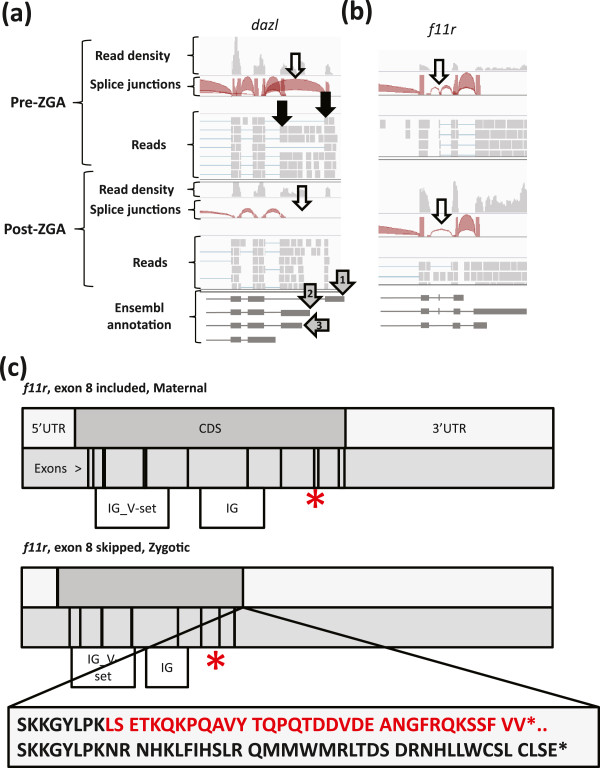
Dazl TSS switching and f11r exon
skipping switch. (a) A screenshot from Integrative Genomics
Viewer shows that dazl has been transcribed from at least two
TSS’s in the maternal transcriptome; grey arrows 1–3 at bottom
indicate Ensembl annotated TSSs. Black arrows in the upper panel indicate reads
supporting promoter 1 (rightmost black arrow) and promoter 2/3 (leftmost black
arrow; our data cannot distinguish between TSS 2 and 3). A white arrow in the
upper panel points at a splice junction ‘bridge’ (red), symbolizing
the splice junction for the most distal first exon. The thickness of splice
junction symbols is correlated with the number of reads supporting the
junction. Post-ZGA transcripts lack the most 5’ exon as can be observed
from the absence of reads supporting the splice junction originating from this
exon (white arrow, bottom panel). (b) Pre-ZGA an f11r isoform
with exon 8 included is present (white arrow, top panel). Post-ZGA a different
f11r isoform, this one with exon 8 lacking, has been transcribed
(white arrow, bottom panel). (c) The f11r exon skipping (red
asterix) leads to a frame shift resulting in a 6 nt longer ORF, including the
removal of two C-terminal valine residues. Two functional domains,
immunoglobulin V-set domain (PF07686) and immunoglobulin domain (PF00047)
(white bars) are intact in both splice isoforms.